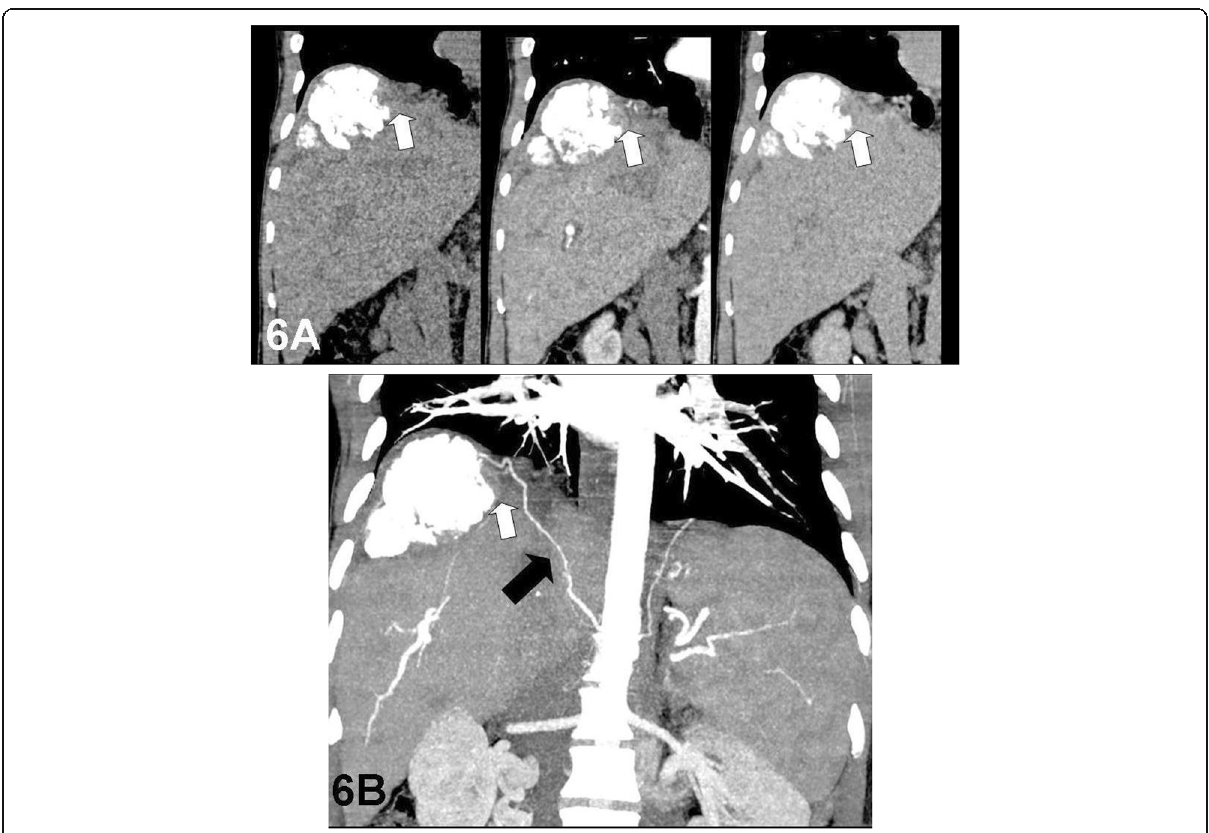
Fig. 6 Follow-up multi-phase CT liver after TACE showing a lipiodol retention with small residual/recurrent activity (white arrows) at the medial portion of the managed lesion at the hepatic dome. b Coronal MIP showing arterial supply of the active portion (white arrow) of the lesion by the right inferior phrenic artery (black